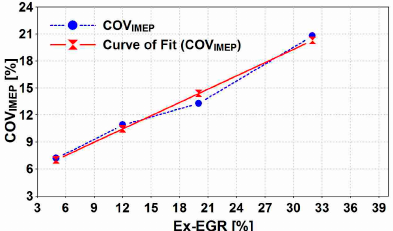
Figure 13. Cyclic variability of IMEP due to variation of Ex-EGR setting (rpm = 3000, IMEP = 2.1 bar, T epc = 525 – 530 K)